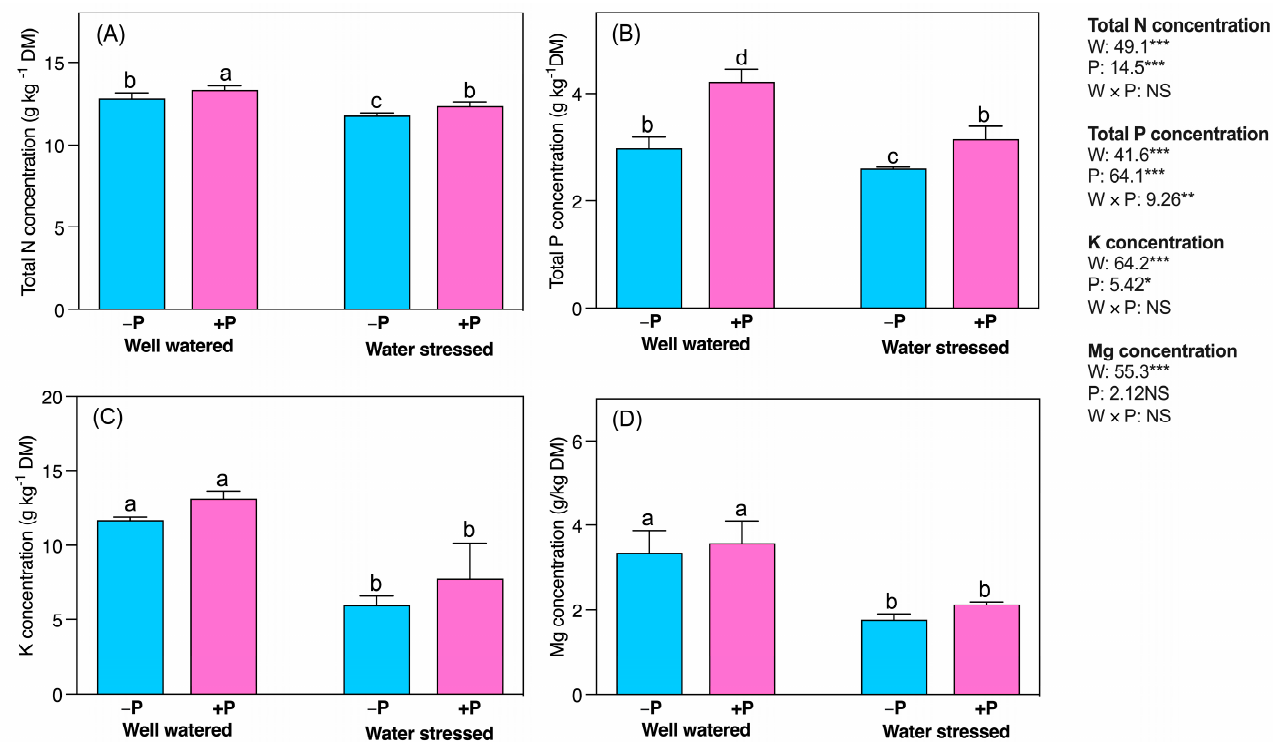
Figure 8. Changes in the concentrations of ( A ) TN, ( B ) TP, ( C ) K, and ( D ) Mg in response to P supplementation, under well-watered and drought-stressed conditions. A different letter following the means indicates significant differences ( p < 0.05) between the four treatments, as determined by Duncan’s test. Bars represent means ± SD. An overview of the two-way ANOVA assessing the effect of water (W) and phosphorus (P) treatments is presented in the right-hand corner of each panel. *, ** and *** indicate that F values were significant at p ≤ 0.05, 0.01, and 0.001, respectively.